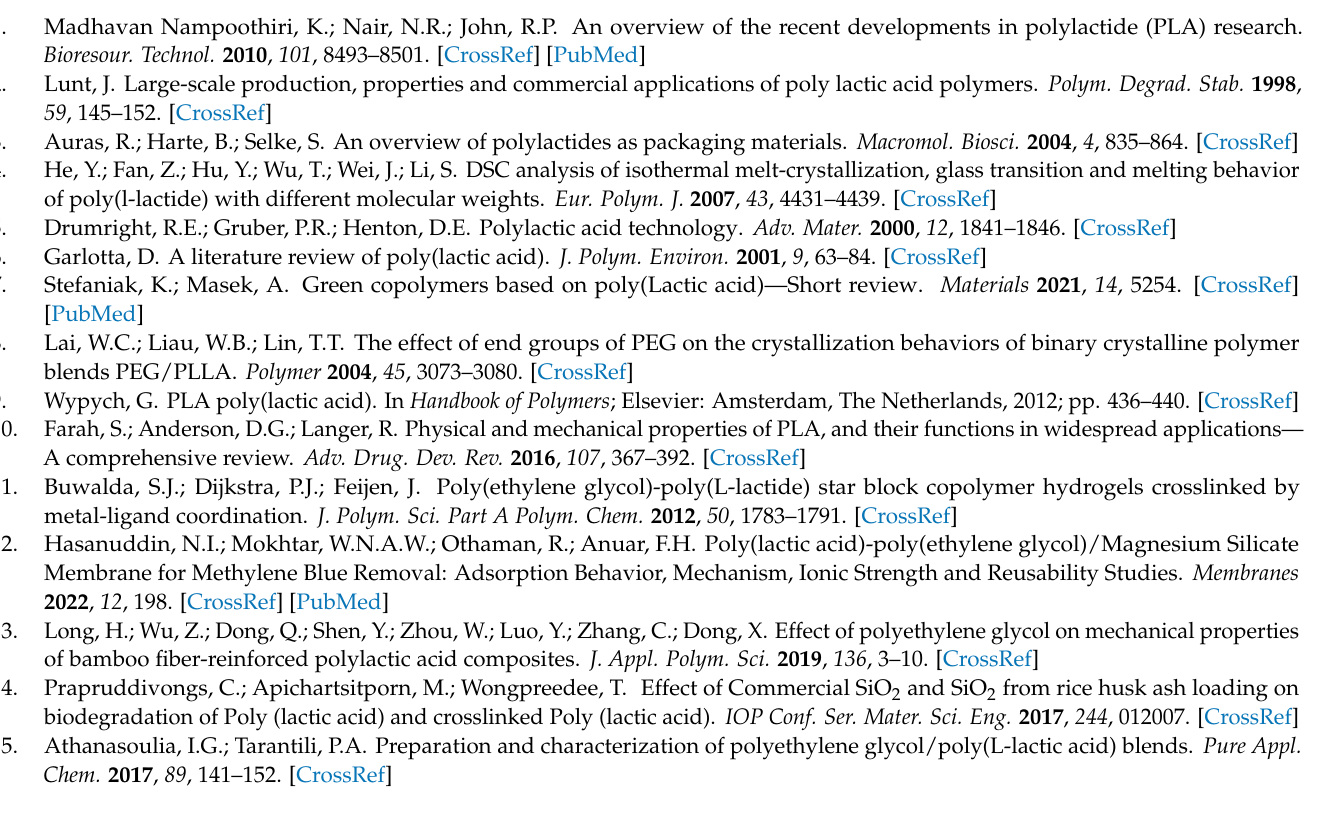
fitting parameters ( n , K , and τ 1/2 ) and their correlation coefficient ( R 2 ). The experimental value theo of τ 1/2 is given for comparison purposes. The conversion range used was the same in each case (5–20%). Figure S2: Variation of 1 − V c (volumetric relative amorphous content) as a function of log ( t − t 0 ) . The lines represent fitting to the Avrami model (Equation (3)) with the parameters of Table 6. The crystallization temperatures were 97, 100, and 107 ◦ C for PLLA, PLLA/SiO 2 (95-5), and PLLA/SiO 2 /PEG (90-10-3), respectively. Figure S3: Variation of the enthalpy of crystallization ( ∆ H c ) as a function of time ( t ) for PLLA, PLLA/SiO 2 (95-5), and PLLA/SiO 2 /PEG (90-10-3). Figure S4: Experimental DSC isotherms and simulated DSC curves by the Avrami equation for PLLA, PLLA/SiO 2 (95-5), and PLLA/SiO 2 /PEG (90-10-3). The crystallization temperatures were 97, 100, and 107 ◦ C for PLLA, PLLA/SiO 2 (95-5), and PLLA/SiO 2 /PEG (90-10-3), respectively. Figure S5: Plots of ln ( 1/ t 1/2 ) + U ( ∗ ) / R ( T c − T ∞ ) as a function of ( 1/T c ∆ T f ) for PLLA, PLLA/SiO 2 (95-5), PLLA/SiO 2 (90-10), and PLLA/SiO 2 (85-15). Figure S6: Plots of ln ( 1/ t 1/2 ) + U ( ∗ ) / R ( T c − T ∞ ) as a function of (1/T c ∆ T f ) for PLLA/SiO 2 /PEG